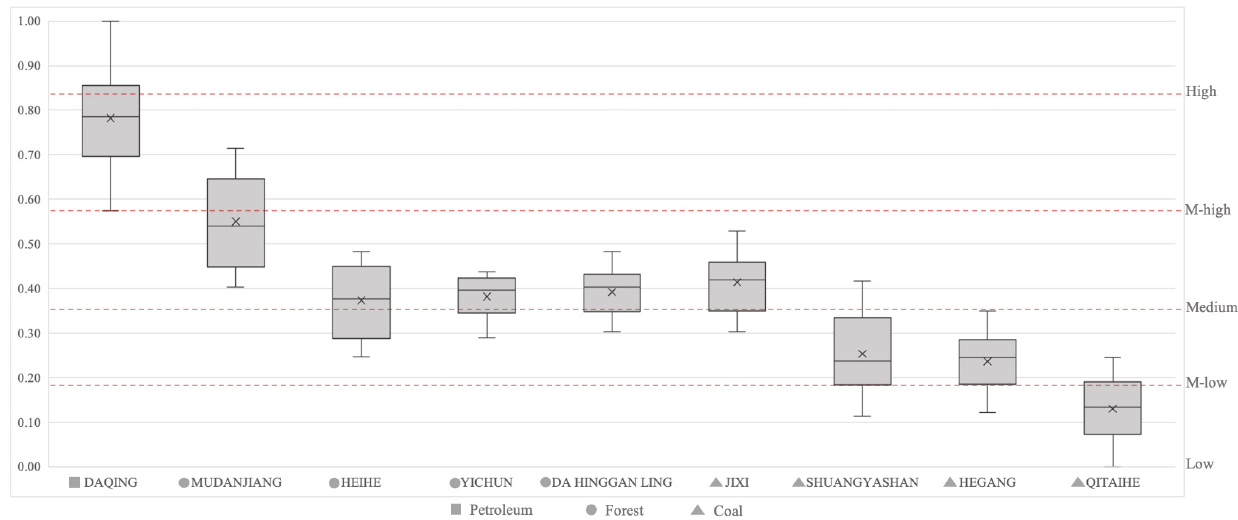
Figure 5. Overall resilience values of 9 RBCs in different grades from 2010 to 2019.